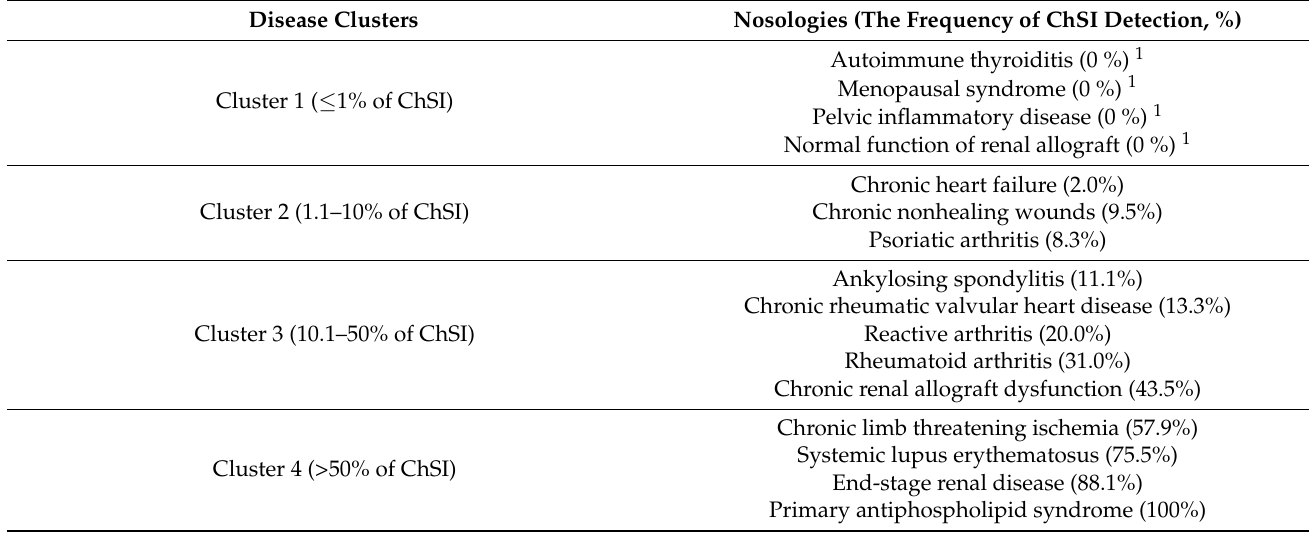
Table 9. The classification of chronic diseases based on the probability of ChSI signs